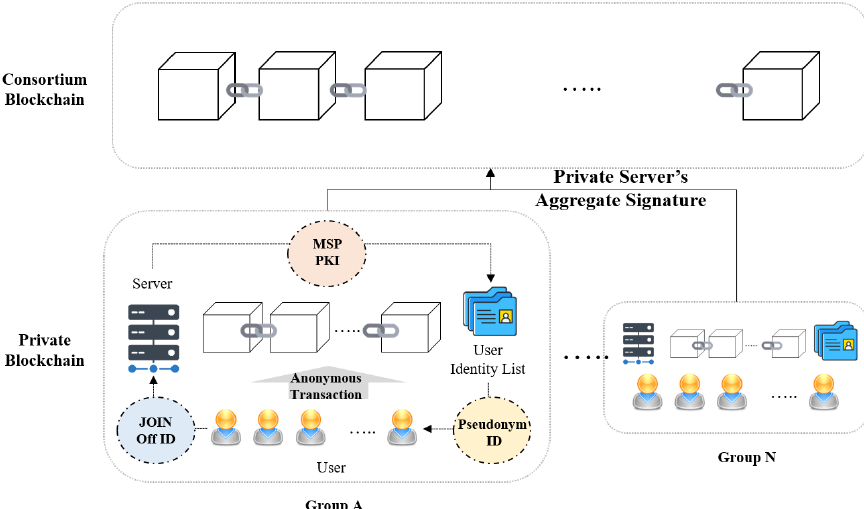
Figure 5. Entities and overview of proposed